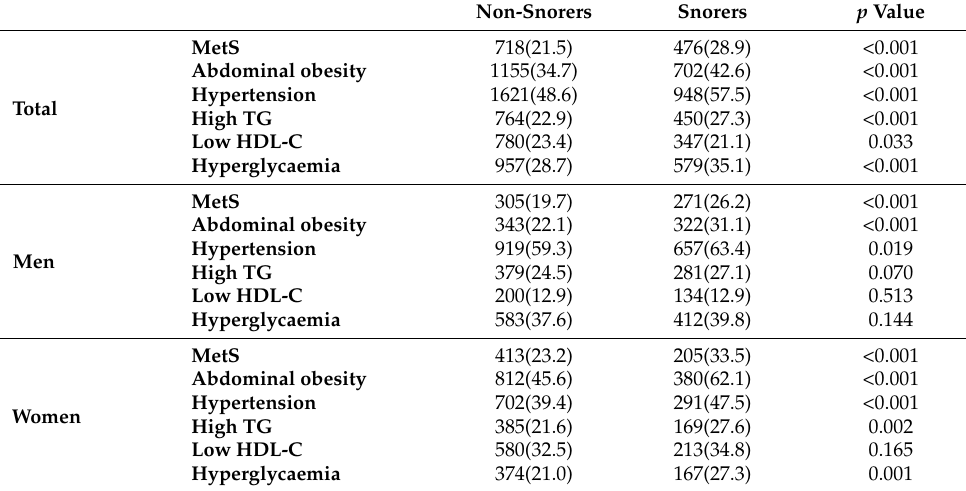
Table 3. Incidence of MetS in non-snorers and